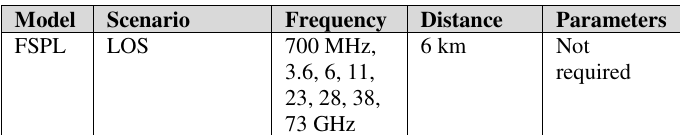
Fig 29. The definition of 3D separation distance TABLE III: PARAMETERS USED FOR